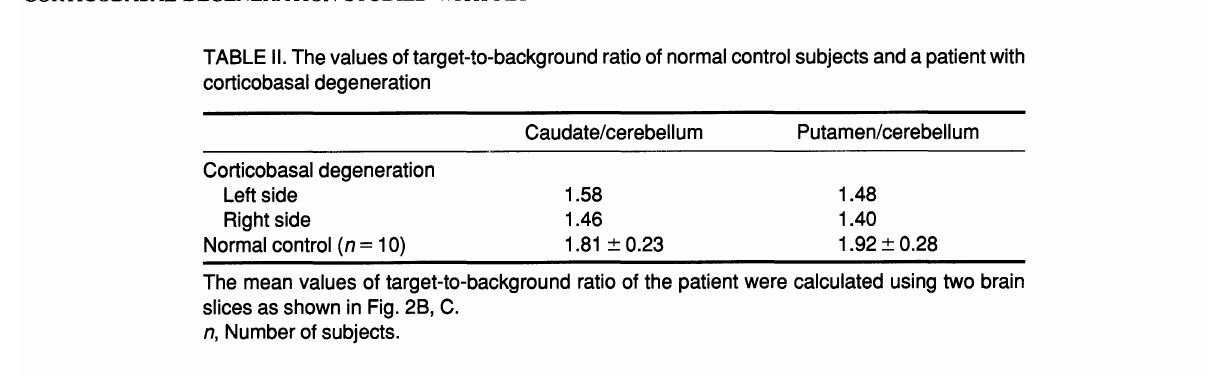
TABLE II. The values oftarget-to-background ratio of normal control subjects and a patient with